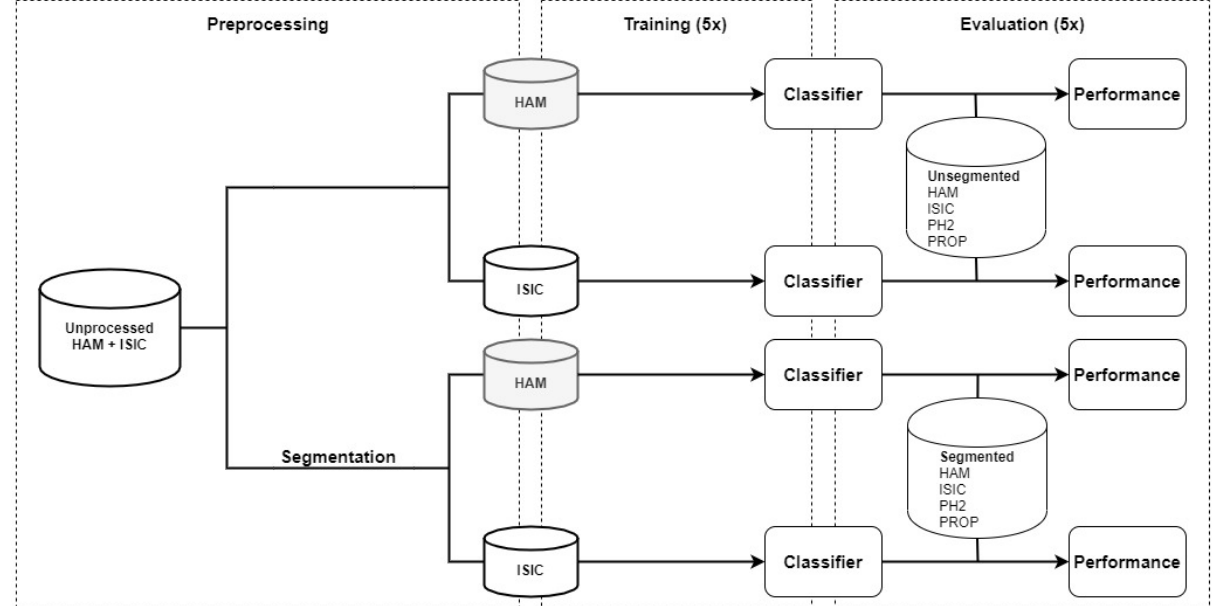
Figure 2. Flowchart of the study design. A training data set consisting of images from 2 different sources was either segmented or not segmented and split into 2 smaller partitions based on image origin (HAM or ISIC). An individual classifier was then trained on each of the 4 training sets and evaluated on a multi-source test set, which underwent a preprocessing step that equaled the training data preprocessing. Training and evaluation were repeated a total of 5 times for a more robust measure. HAM: human against machine data set; ISIC: international skin imaging collaboration data set; PH2: hospital Pedro Hispano data set; PROP: proprietary data